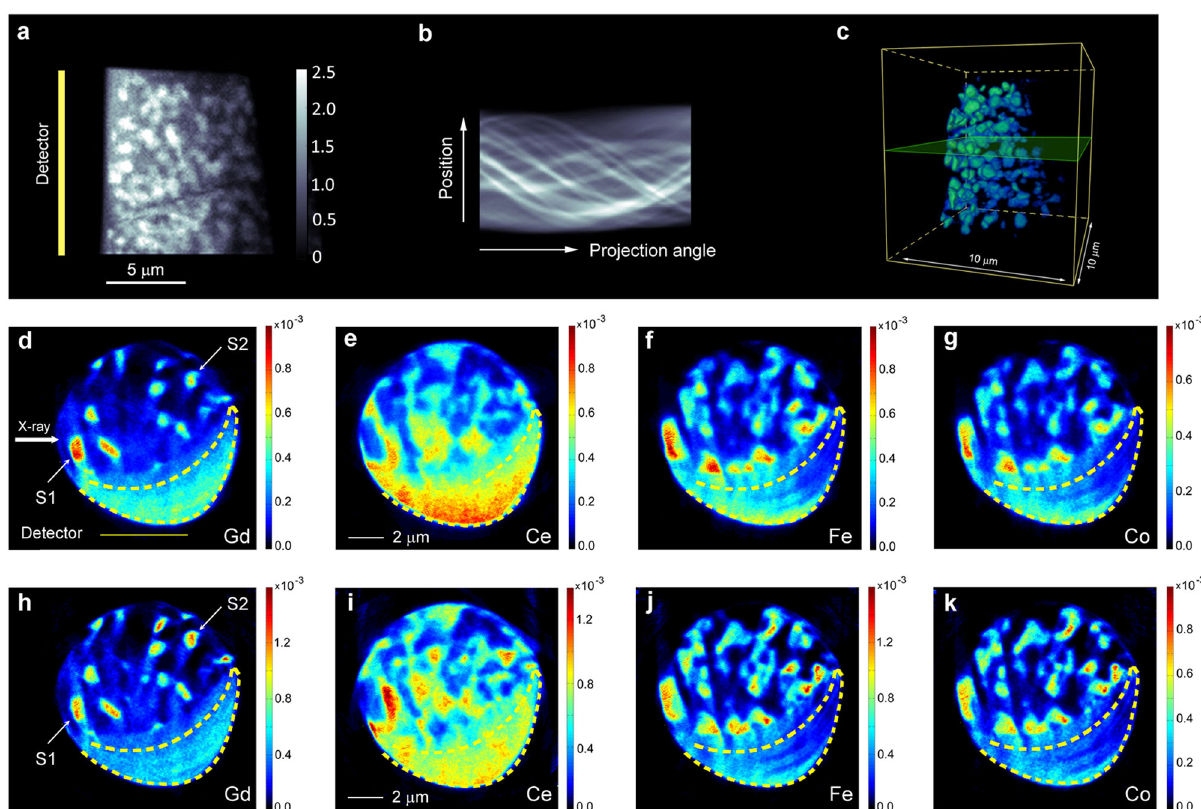
Fig. 2 Comparison of 3D tomography reconstruction without and with absorption correction. a 2D fl uorescence projection image of Gd. The color bar indicates the relative pixel intensity in the fl uorescence image. b Sinogram from a single slice of the sample collected − 90° to 90° with a 3° interval. Note that the absorption is responsible for a systematic decrease in XRF intensity in a and sinogram b . c reconstructed 3D volume of Gd distribution without correction. d – g 2D cross-sectional slice view of 3D elemental distribution for Gd ( d ), Ce ( e ), Fe ( f ), and Co ( g ) without absorption correction. For the sample coordinate used for d – k the detector is on the bottom side of the image. h – k corresponding 2D slice views after absorption correction. After the absorption correction, the intensity of particles, P1 and P2, became comparable. The dashed region in d – k shows the metal redeposition in the FIB process, which is excluded in the quantitative